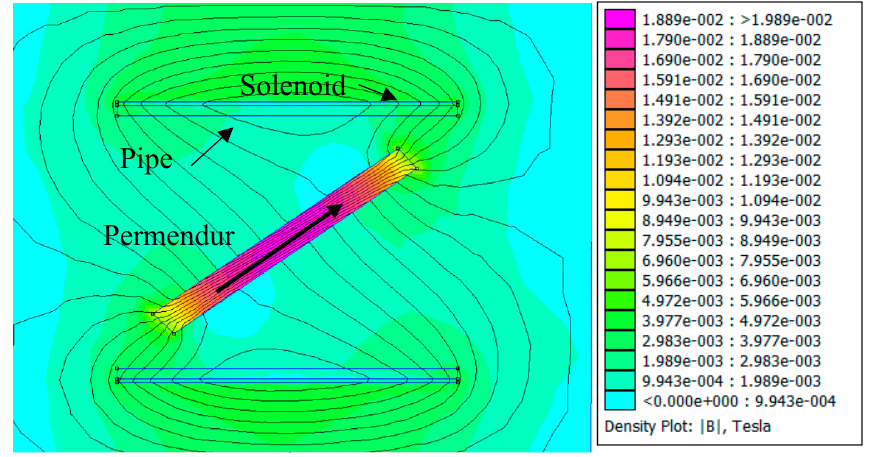
Figure 8. Activation pulse of the magnetostrictive transducer.